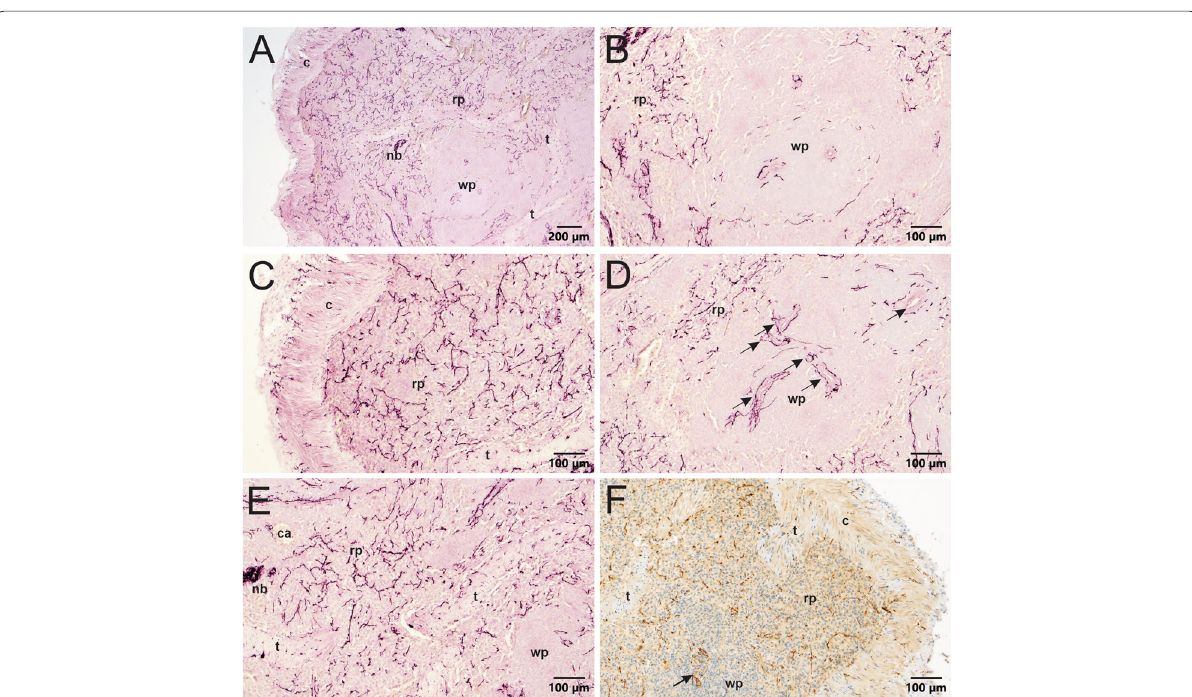
Fig. 6 Regional distribution of abundant TH nerves in porcine spleen. Sections shown in A-E were developed using VIP purple chromogen, and + section in F was developed using DAB brown chromogen and counterstained with hematoxylin. A Low magnification image showing sympathetic innervation in capsule (c) and nearby parenchyma. TH nerve fibers are most evident in the capsule and red pulp (rp), although some also occur + in the white pulp (wp). Trabeculae (t) extend from the capsule into the red pulp. B Higher magnification of white pulp region of panel A showing TH nerves around the central arterioles of the white pulp and in the red pulp. C Image showing TH nerves in the capsule extending toward + + the heavily innervated red pulp. D Central arterioles (indicated with arrows) are surrounded by TH nerves that run in the adventitia and extend + into the white pulp. E Image illustrating the contrast of innervation in the white pulp, red pulp, and trabeculae. Red pulp is heavily innervated throughout. Nerves in the white pulp mainly extend from the central arteriole. TH nerves occur within and along trabeculae. Nerve bundles (nb) + are also common in the parenchyma of pig spleens. F Brown TH nerves in parenchyma near the capsule (c) and trabeculae (t). Arrow indicates + central arteriole surrounded by nerves. Note nerves in trabecula exiting the